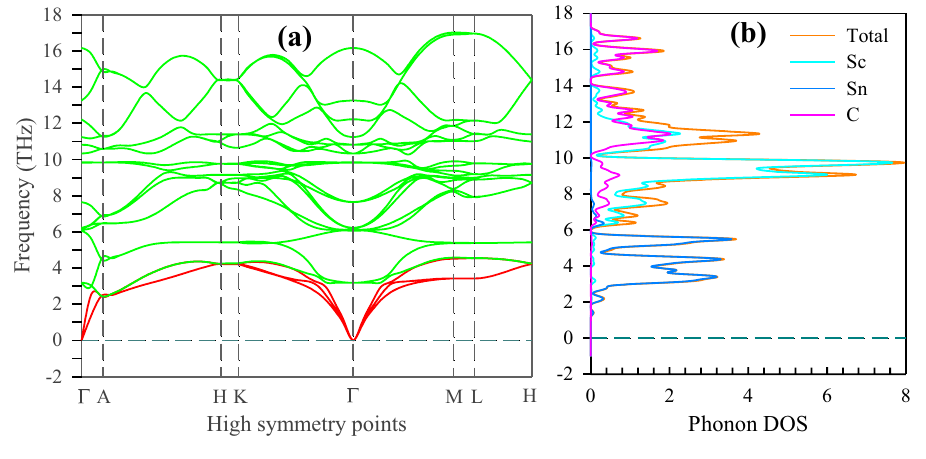
Figure 8. ( a ) Phonon dispersion and ( b ) Phonon